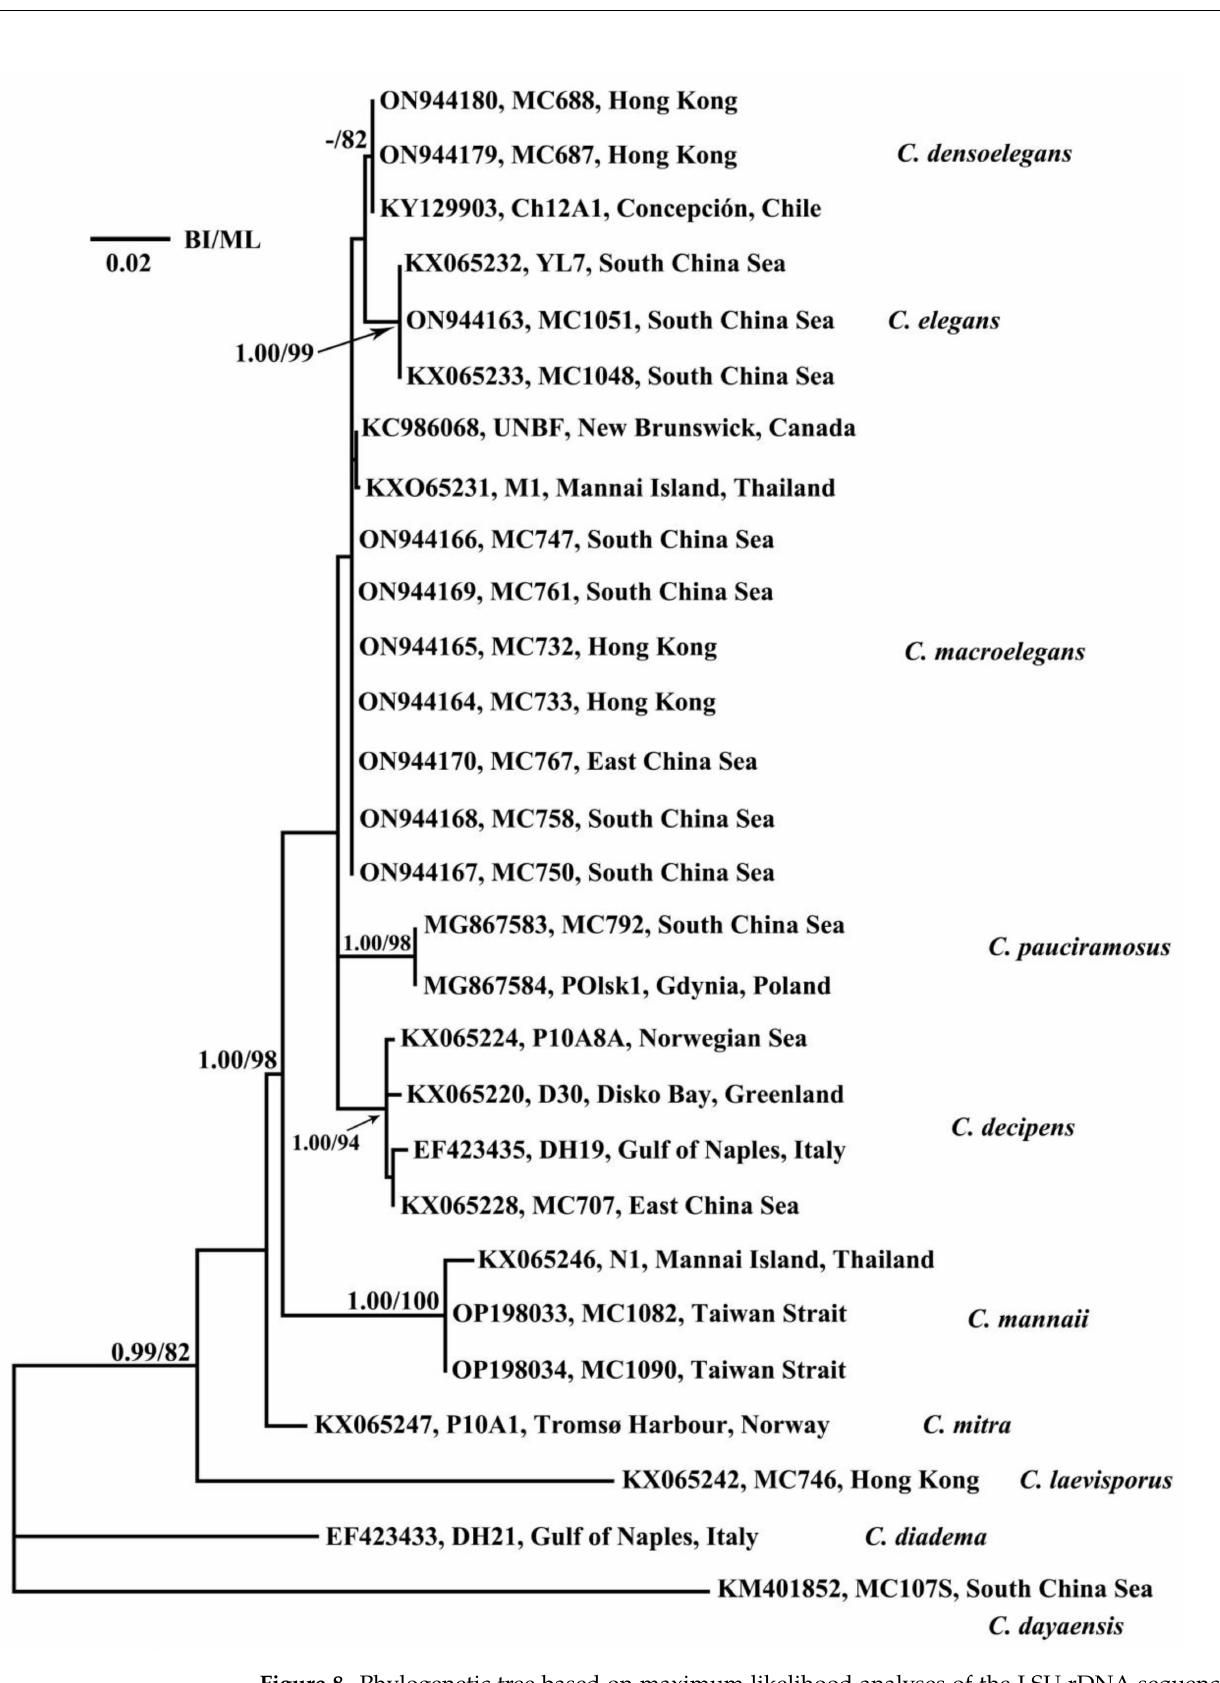
Figure 8. Phylogenetic tree based on maximum likelihood analyses of the LSU rDNA sequences. Only bootstrap support from Bayesian analyses (MrB) ≥ 0.95 and maximum likelihood (ML) ≥ 70% are